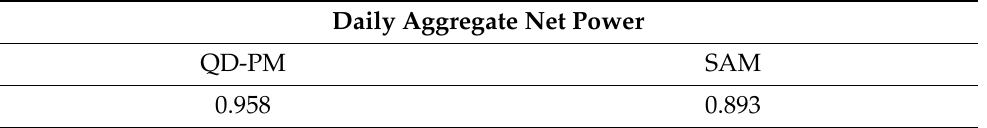
Table 4. R 2 Net energy daily aggregate validation comparison between QD-PM and SAM.